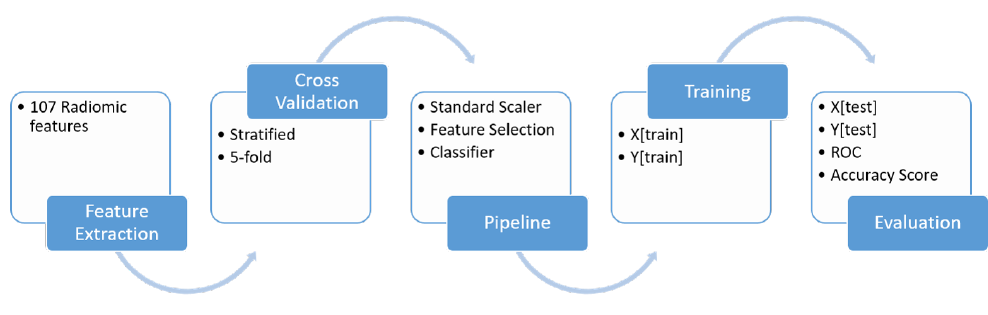
Figure 3. Pipeline evaluation